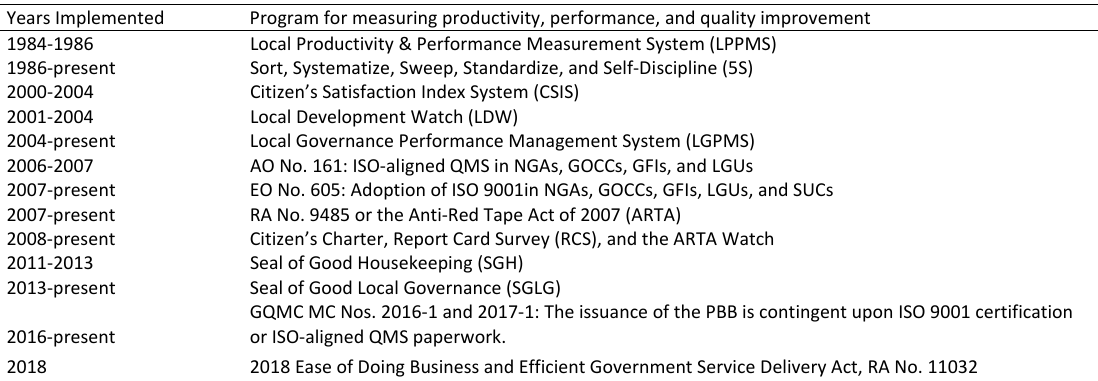
Table 1: Philippine Government programs for productivity, performance, and quality improvement. (De Leon, 2017b).